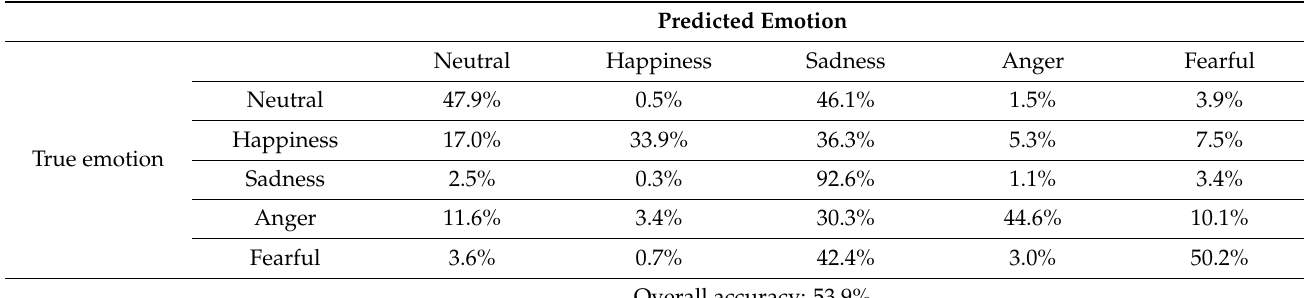
Table 5. Confusion matrix of the emotion classification results of the proposed cascaded DnCNN–CNN that was trained on the Korean CADKES mixed with the PSTATION noise.